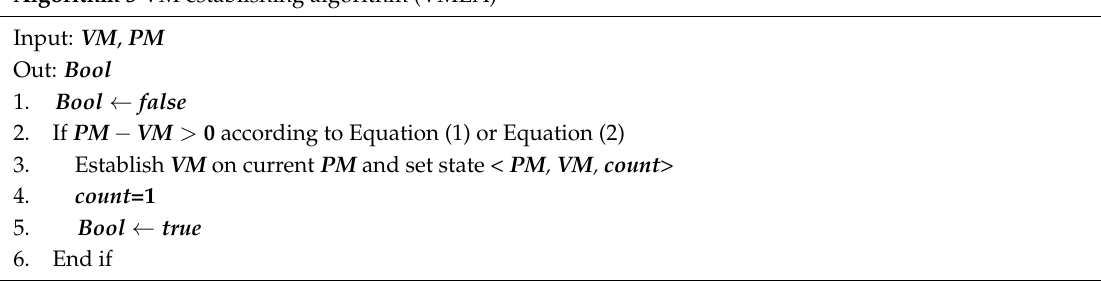
Algorithm 3 VM establishing algorithm